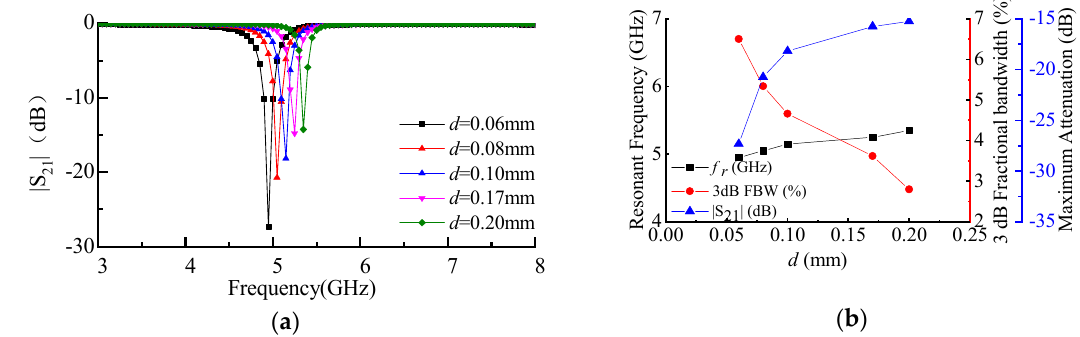
Figure 3. ( a ) Simulation results with different d by using HFSS. ( b ) Resonant frequency, maximum attenuation, and 3 dB Fractional Bandwidth with different d.